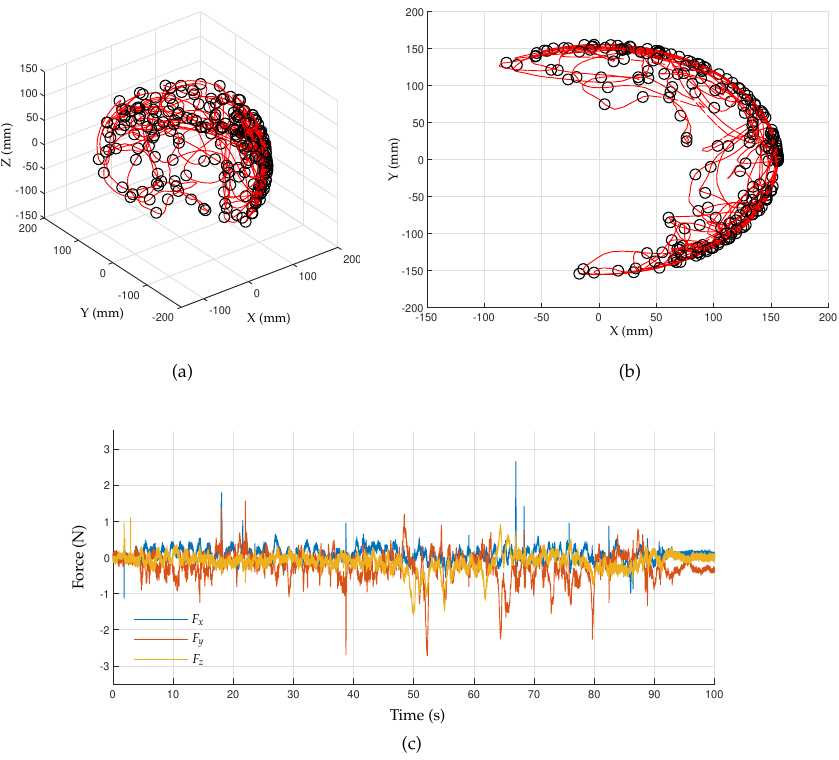
Figure 16. Experimental results for back-drivability: ( a ) trajectories of arbitrary motions generated by the operator; ( b ) top view of the trajectories; ( c ) force measured according to arbitrary human motions.